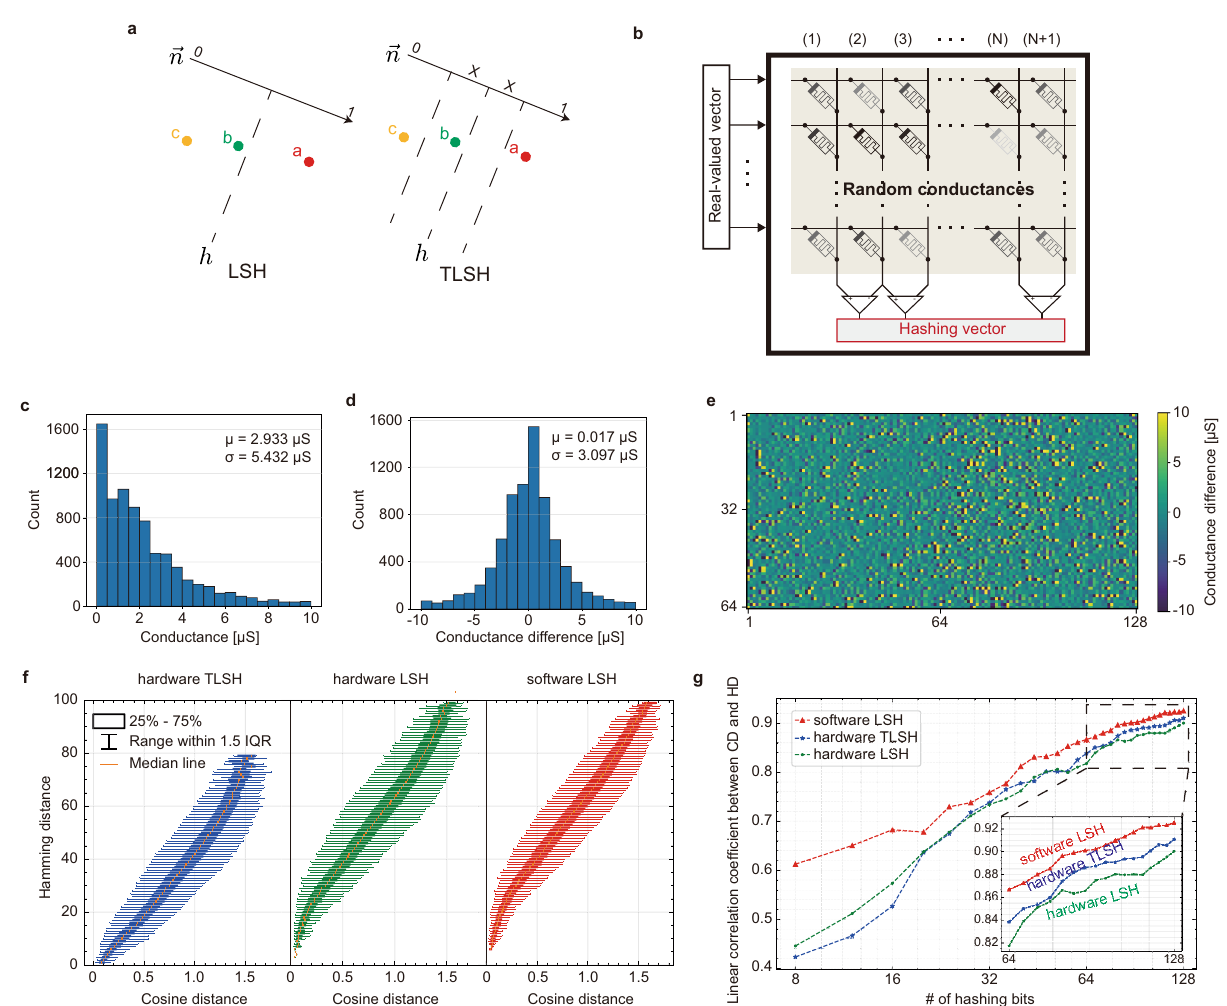
Fig. 2 | Robust ternary locality sensitive hashing in analog memristive cross- bars.a Illustrationofthe Locality Sensitive Hashing (LSH)andthe Ternary Locality Sensitive Hashing (TLSH) concept. b The LSH or TLSH implemented in memristor crossbars. Each adjacent column pair represents one hashing plane. Thus, cross- bars with N +1 columns can generate N hashing bits with this method. Greyscale colorsonthememristorsymbolrepresentrandomconductancestates. c Arandom memristor conductance distribution in a 64×129 crossbar after applying fi ve RESETpulsestoeachdevice.Theintrinsicstochasticbehaviorinmemristordevices results in a lognormal-like distribution near 0 μ S. d The distribution of the mem- ristor conductance difference for devices in adjacent columns. The differential